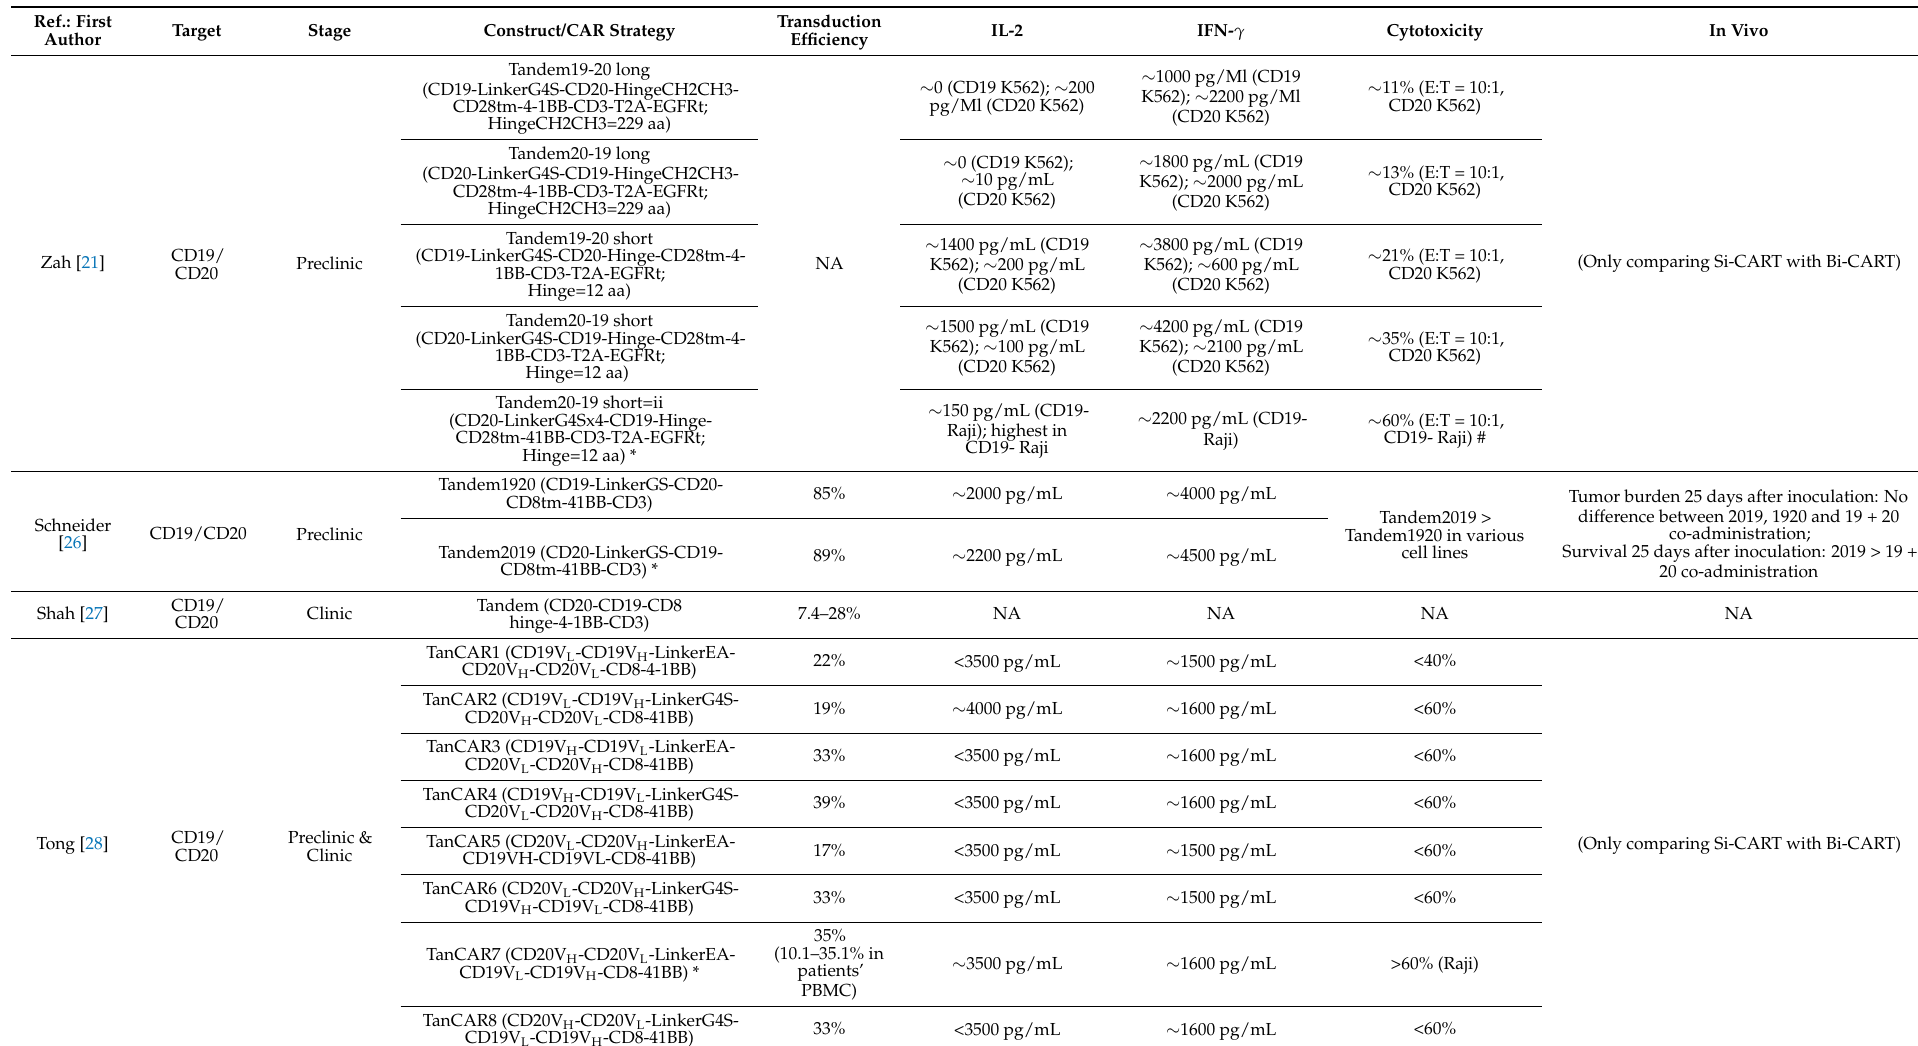
Table 2. Comparison of transduction efficiencies and effects among different dual CAR strategies in vitro and in